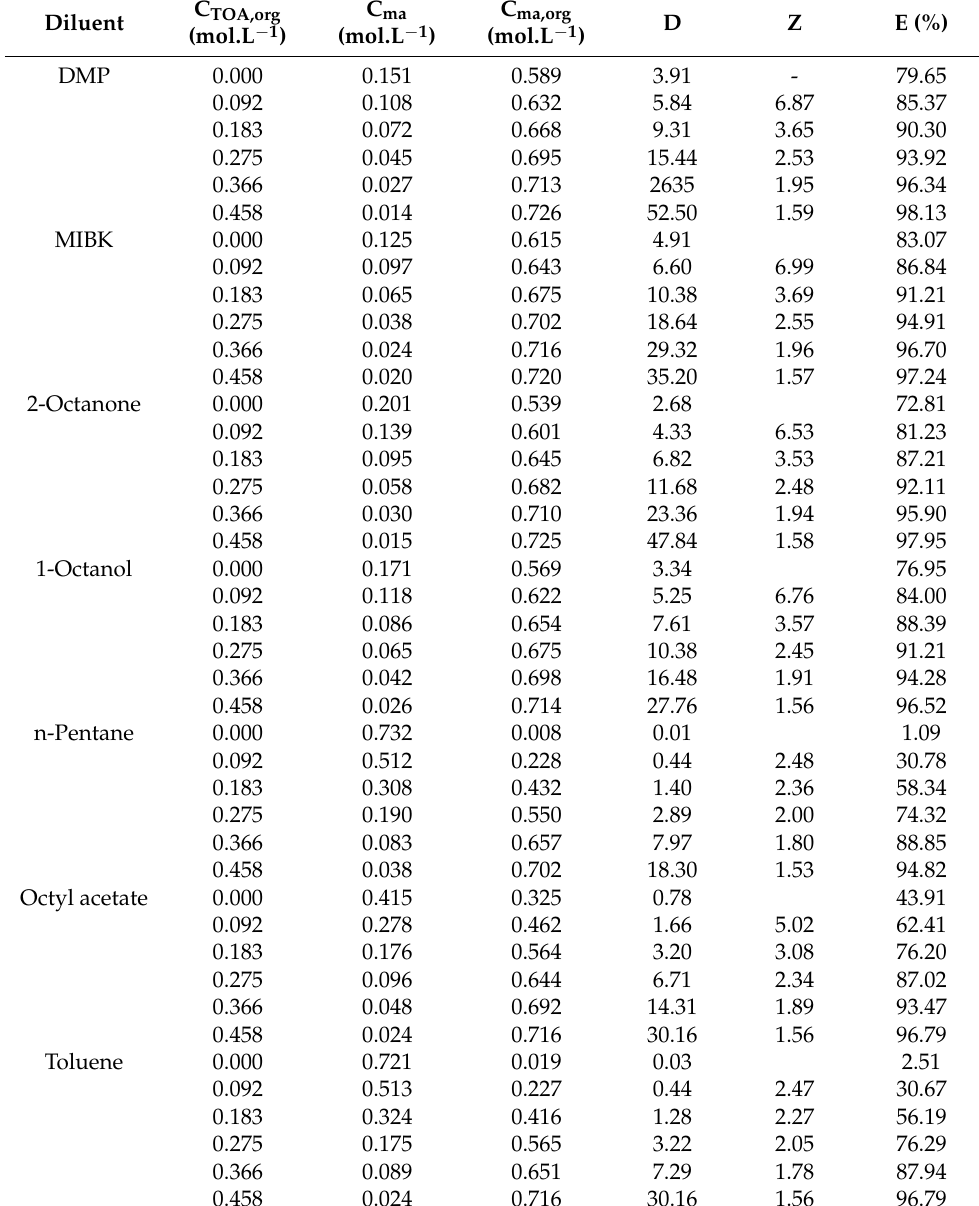
Table 2. Molar concentrations of mandelic acid in water/organic diluents and variations in the loading factor (Z), distribution coefficient (D), and extraction efficiency (E) at 298.15